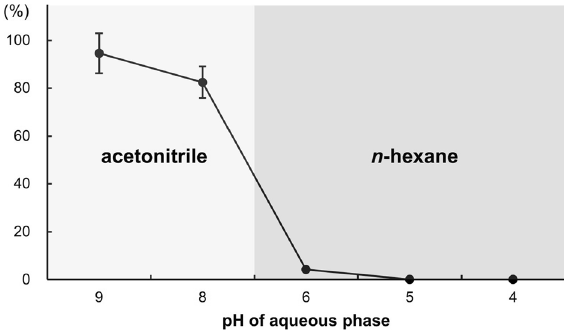
Figure 4. Partition efficiencies of nereistoxin with acetonitrile or n -hexane at various pH values.